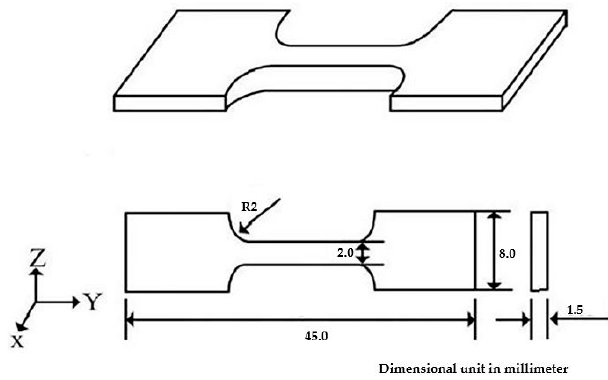
Figure 7. Dimensions of the tensile specimens (mm).